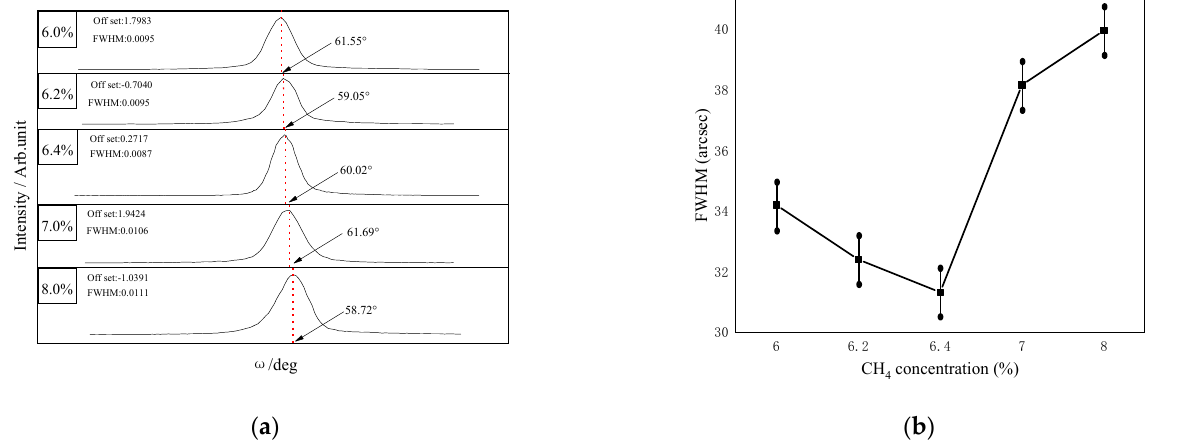
Figure 5. ( a ) Diamond (400) XRD rocking curve; ( b ) the corresponding FWHM values of substrates prepared with different concentrations of CH 4 .